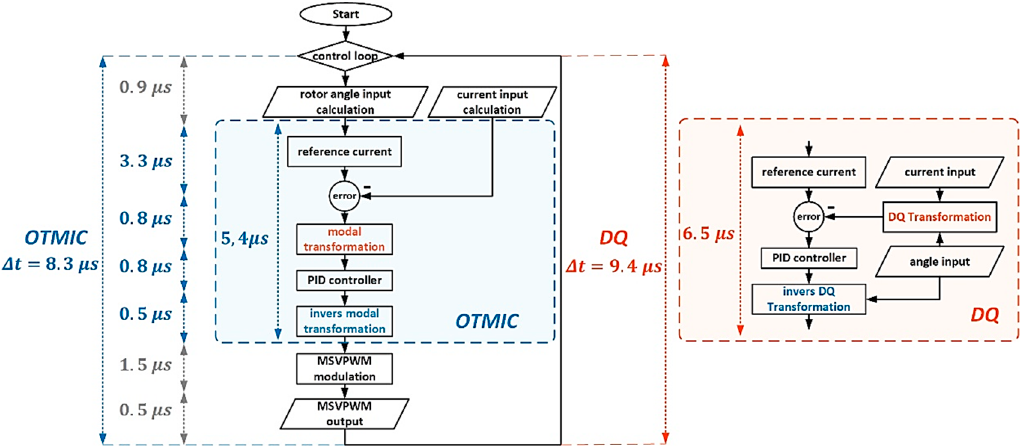
Figure 5. Step response of simulated and measured torque for OTMIC and FOC (DQ).